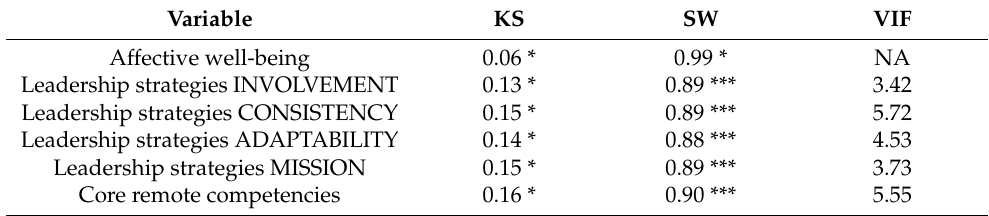
Table 5. Determination of the normality of variable distribution in the model and the analysis of predictor